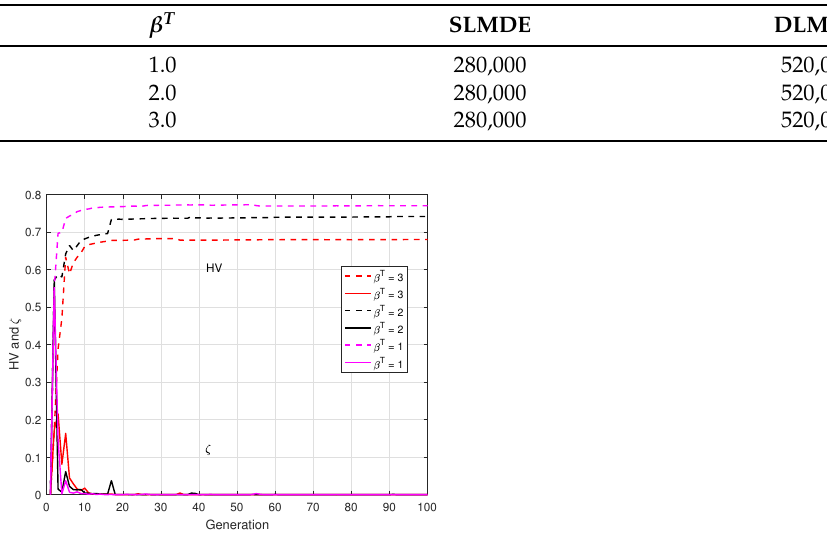
Figure 9. Progress of hypervolume and ζ of SLMDE with respect to number of generations for Example